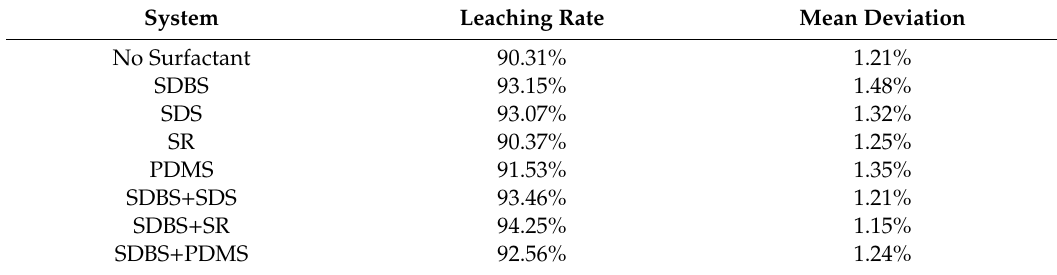
Table 9. Of the species of surfactant on the leaching rate of phosphate rock.